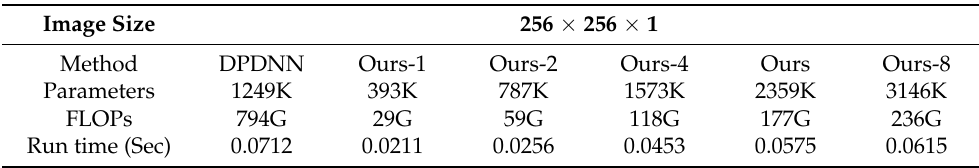
Table 3. Parameters and FLOPs of DPDNN and our method with different iteration number in the deblurring tasks.